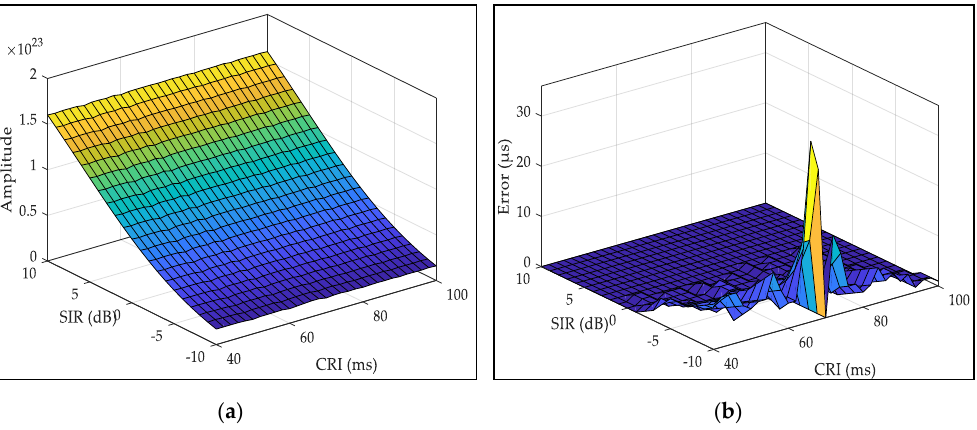
( b ) Figure 11. The acquisition performance as a function of SNR: ( a ) acquisition probability; ( b )